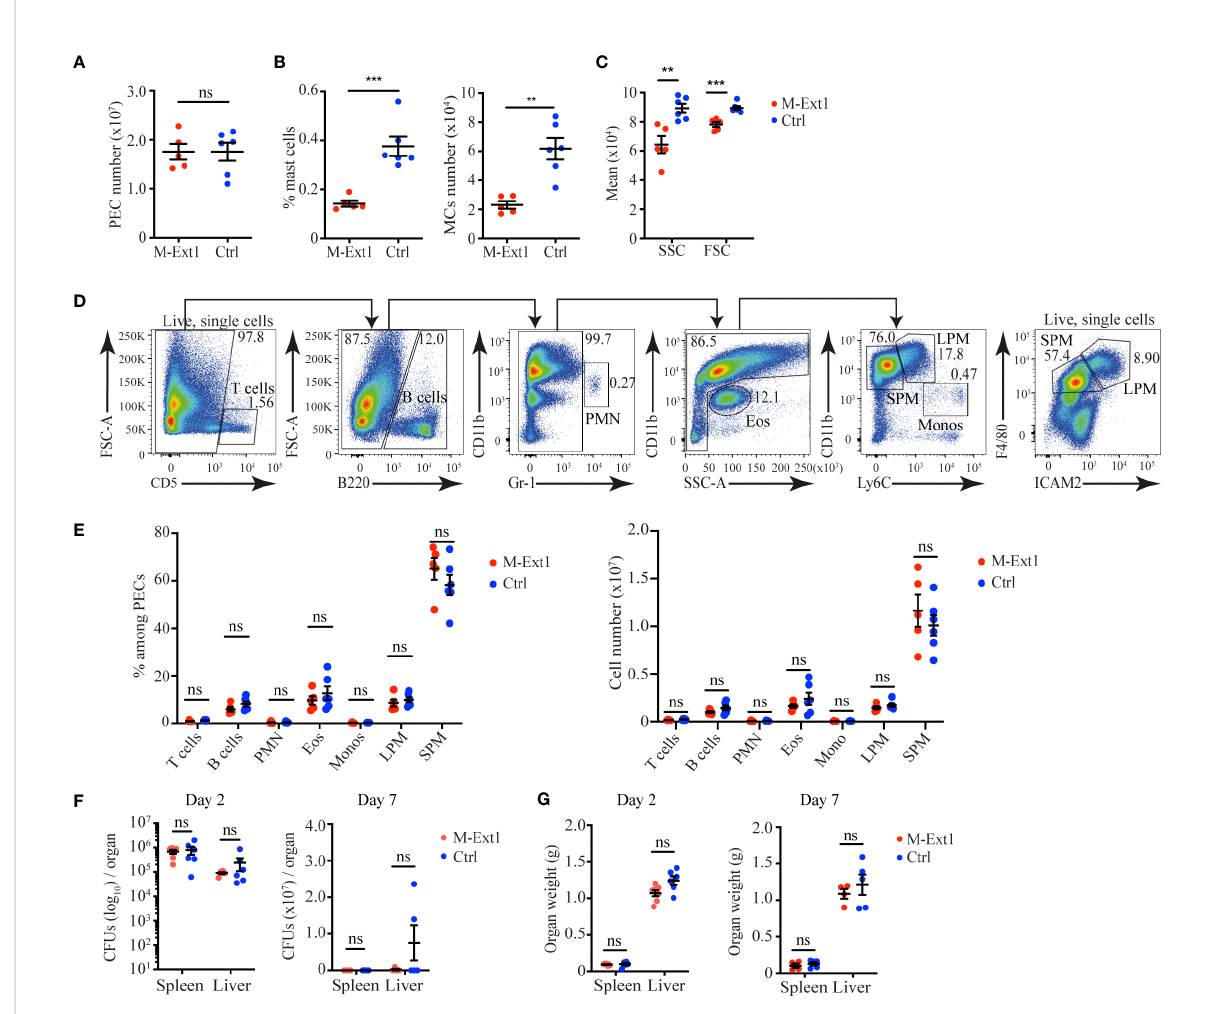
FIGURE 4 Unimpaired recruitment of in fl ammatory cells in M-Ext1 mice during sterile peritonitis and pathogen clearance during bacterial peritonitis in 6- weeks old mice. (A) The total number of peritoneal exudate cells isolated from the peritoneal cavity of M-Ext1 and control mice at day 4 post intraperitoneal injection with 4% Thioglycolate. (B) MCs percentages and numbers among peritoneal cells at day 4 after Thioglycolate injection in M-Ext1 and control mice. (C) Geometric means of size (FSC) and granularity (SSC) of peritoneal cavity MCs from M-Ext1 and control mice injected intraperitoneally with 4% Thioglycolate 4 days in advance. (D) Gating strategy for identifying different populations within the peritoneal exudate cells. (E) Percentages and numbers of different cell populations isolated from the peritoneal cavity of M-Ext1 and control mice injected intraperitoneally with 4% Thioglycolate 4 days in advance. (F) Bacterial burden in spleens and livers from M-Ext1 and control mice infected intraperitoneally with L. monocytogenes determined at day 2 and day 7 post-infection. (G) Weights of spleens and livers from L. monocytogenes infected M-Ext1 and control mice determined at day 2 and day 7 post-infection. Results are represented as mean ± SEM. Each symbol in the graphs is an individual mouse. Data in (A – C , E) are from 5-6 mice per group. Flow cytometry plots in (D) are representative of 6 individual experiments. Data in (F, G) are from 5-6 mice per group. Statistical signi fi cance was determined by unpaired Student ’ s t-test, except for (F) , in which non-parametric Mann- Whitney test was used. Values of p<0.05 were considered statistically signi fi cant, **p<0.01, ***p<0.001, ns, not signi fi